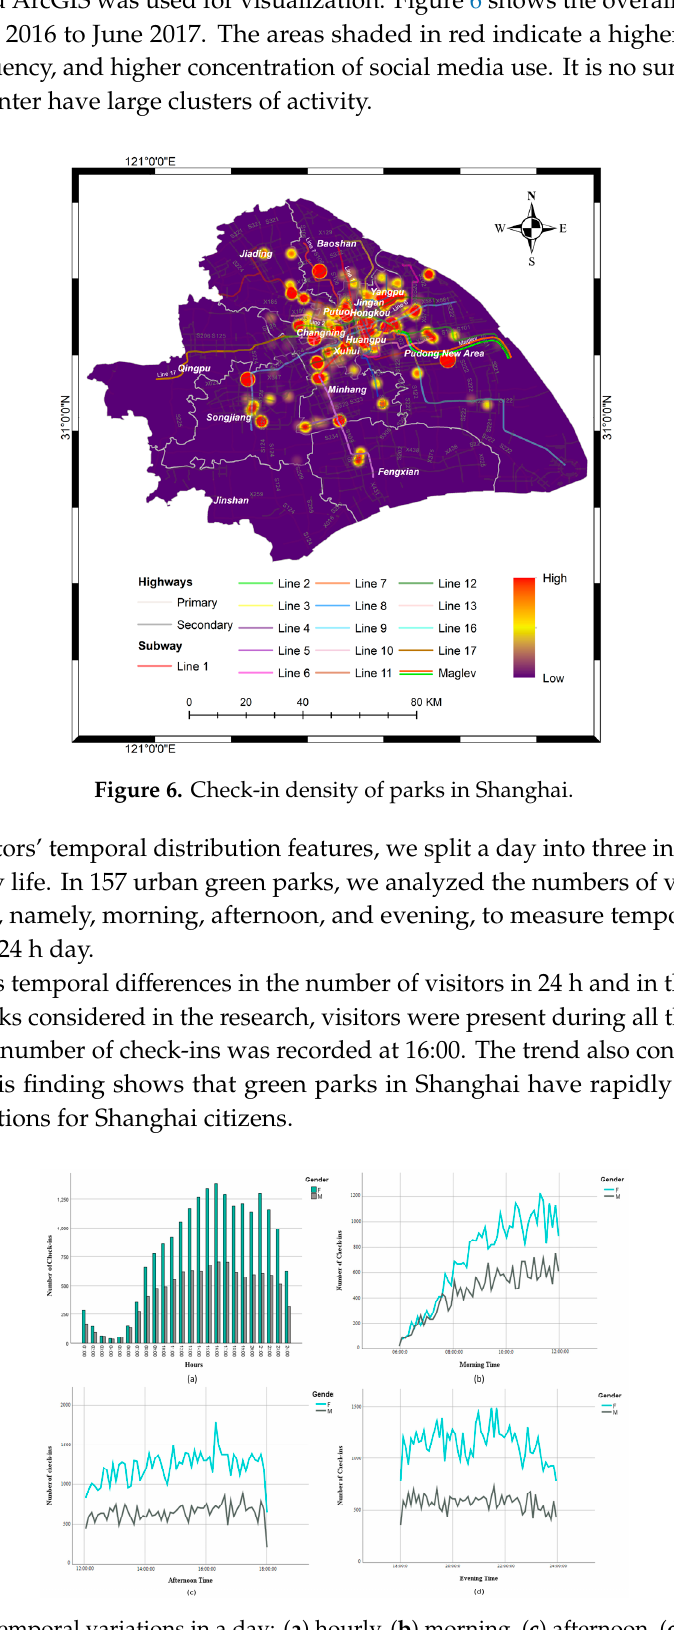
Figure 7. Temporal variations in a day: ( a ) hourly, ( b ) morning, ( c ) afternoon, ( d ) evening.